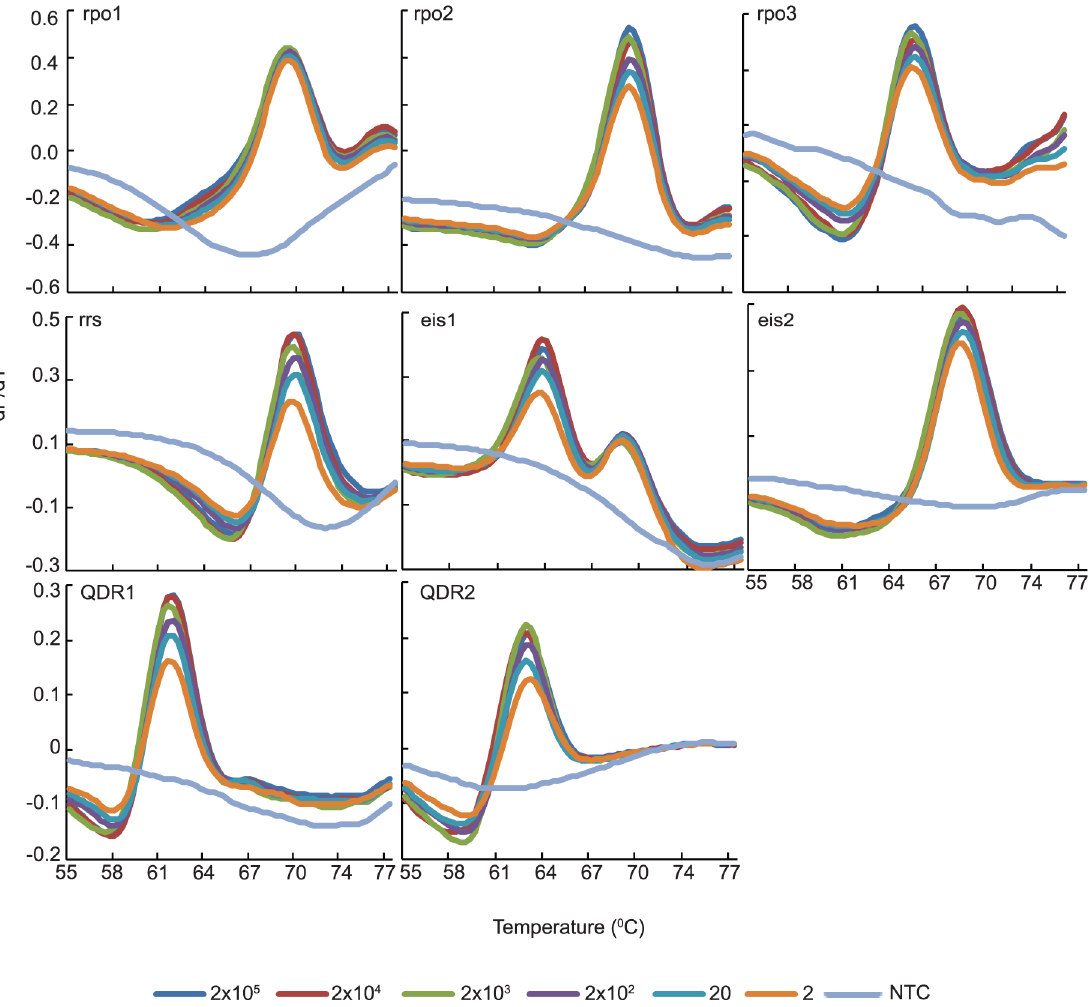
Fig 1. Analytical sensitivity of the SMB assays. Melting temperature first derivative peak profiles of the targets tested for the SMB probes on serial dilutions of M . tuberculosis H37Rv genomic DNA. Input DNA amount is indicated as genome equivalents.